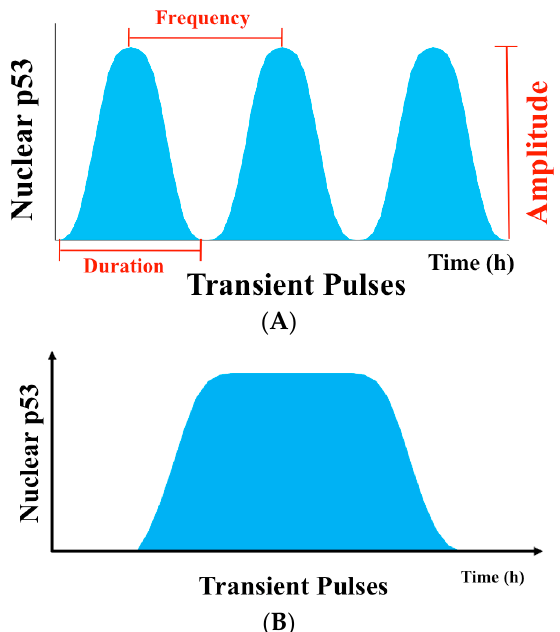
Figure 1. p53 dynamics in damage response. ( A ) p53 dynamics can be measured at the levels of frequency, amplitude, and duration; ( B ) A single prolonged pulses of p53 induced by UV radiation.